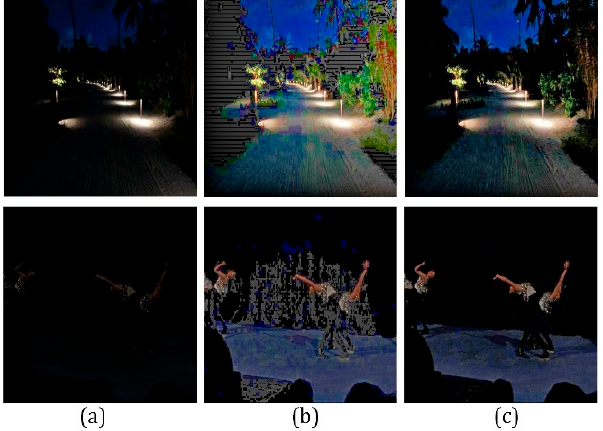
Figure 17. ( a ) Two original images; ( b ) Restored images without noise suppression; ( c ) Enhanced images with noise suppression.